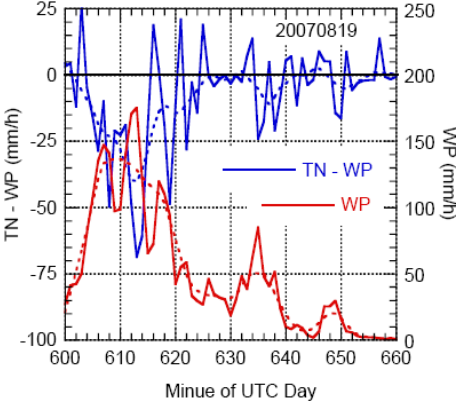
Fig. 6 One-minute average wind speeds at 2-m height during first 60-minute period. Fig. 7 Same as Fig. 5 but for second 60-minute period. Fig. 7. Same as Fig. 5 but for second 60-min 10